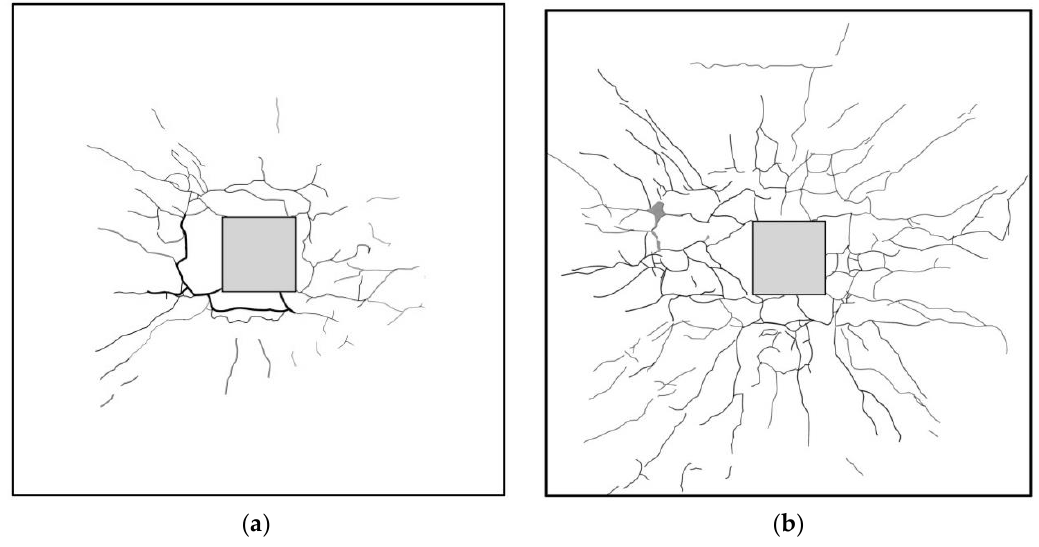
Figure 6. Distribution of cracks on specimens at maximum load: ( a ) Control; ( b ) G-246B.